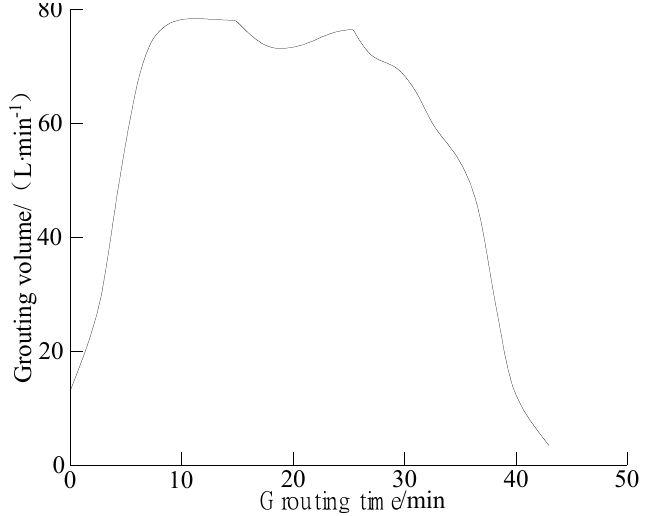
Figure 7. Relation between grouting flow and time.